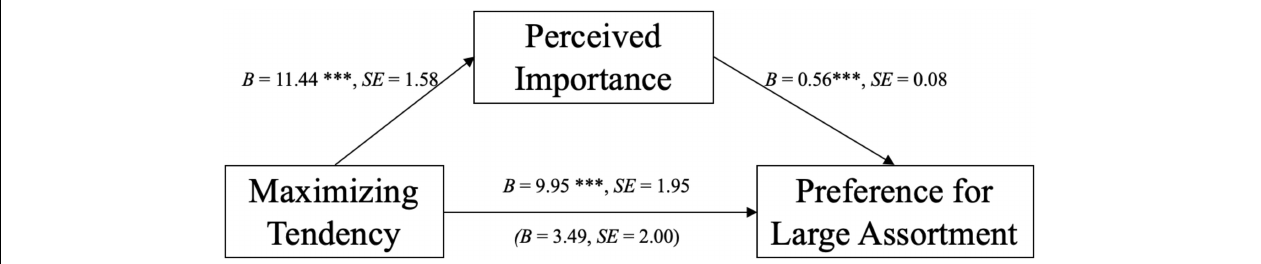
FIGURE 2 | Mediation from Study 2. The value above the dashed arrow indicates the total effect of maximizing tendency on preference for a large assortment, not accounting for mediator. The value under the dashed arrow indicates the direct effect of maximizing tendency on preference for a large assortment, with perceived importance included as the mediator. ∗∗∗ p <